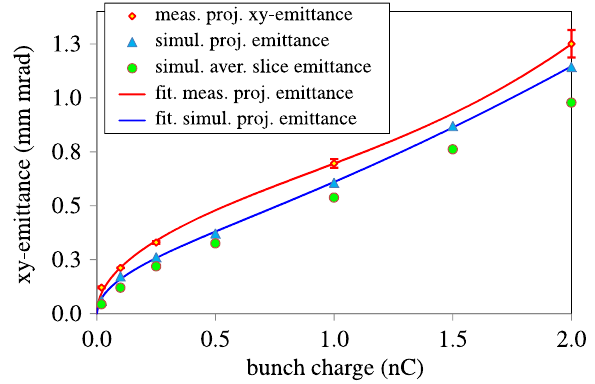
FIG. 13. Measured rms normalized emittance as a function of bunch charge. The blue and the green markers present the results of the beam dynamics simulations for various charges from Table I. The red and blue curves for the measured and simulated projected emittance were obtained using the formula " p ffiffiffiffiffiffiffiffiffiffiffiffiffiffiffiffiffiffiffiffiffiffiffiffiffiffiffiffi a (cid:5) q þ b (cid:5) q c (see text for more